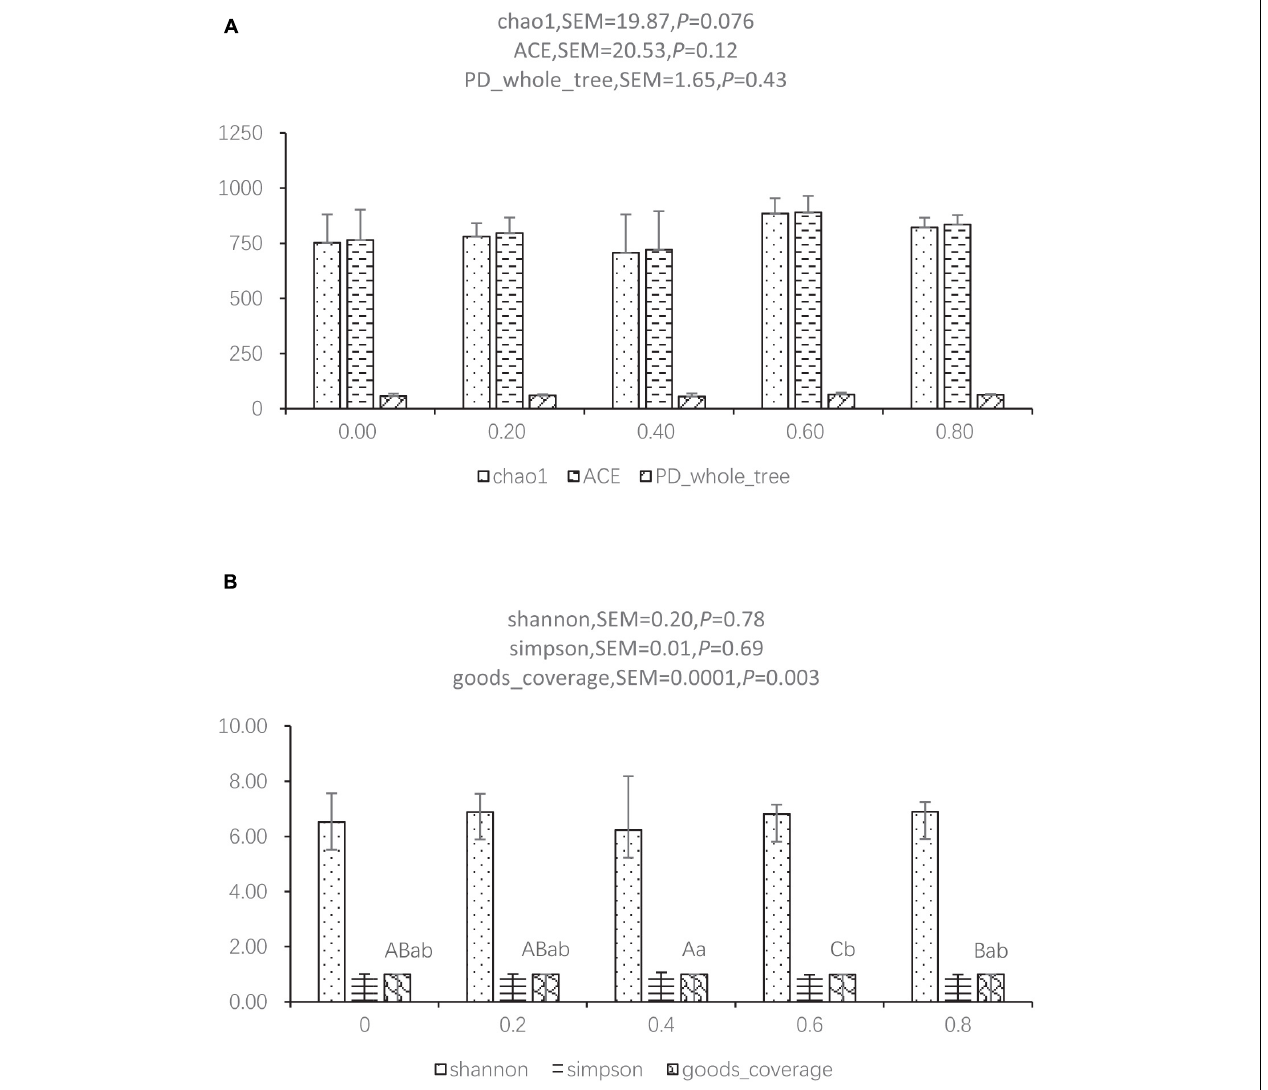
FIGURE 2 | Alpha diversity index between different DAR groups represented by chao1, ACE, PD_whole tree (A) and shannon, simpson, and goods coverage (B) .